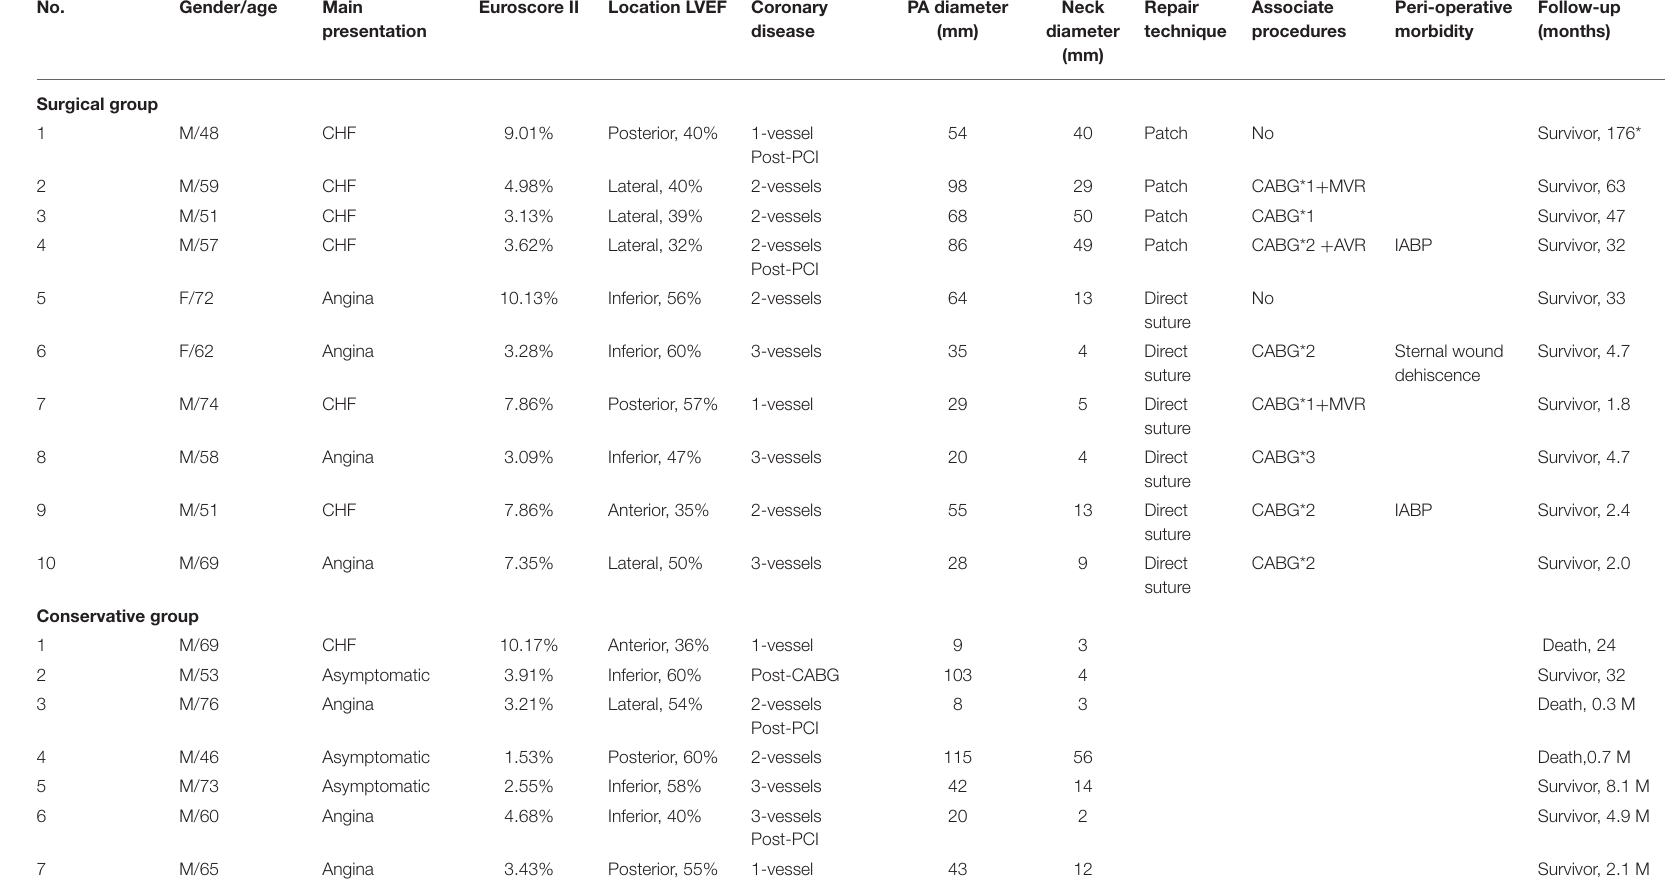
TABLE 1 | Clinical characteristics of patients with LV pseudoaneurysm. No.